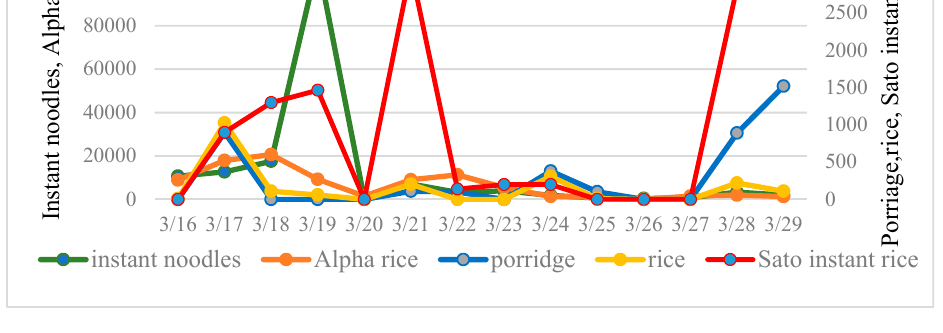
Figure 3. Supply of rice and noodle products.